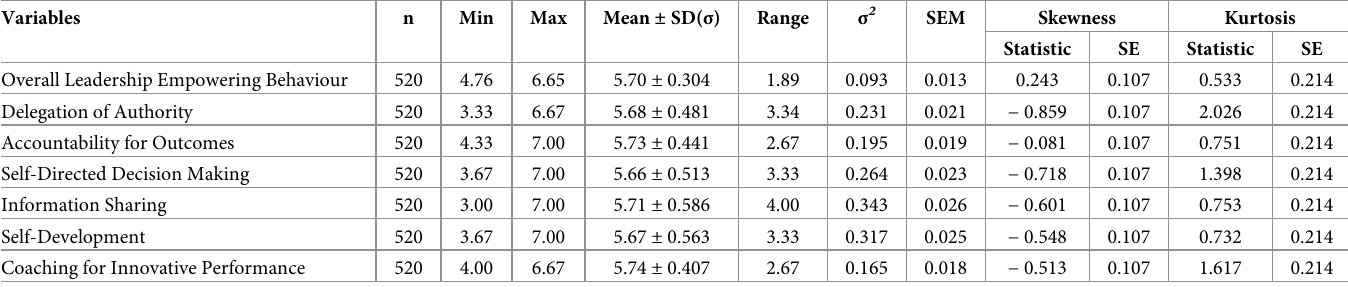
Table 4. Descriptive analysis of the principals’ leadership empowering behaviour.